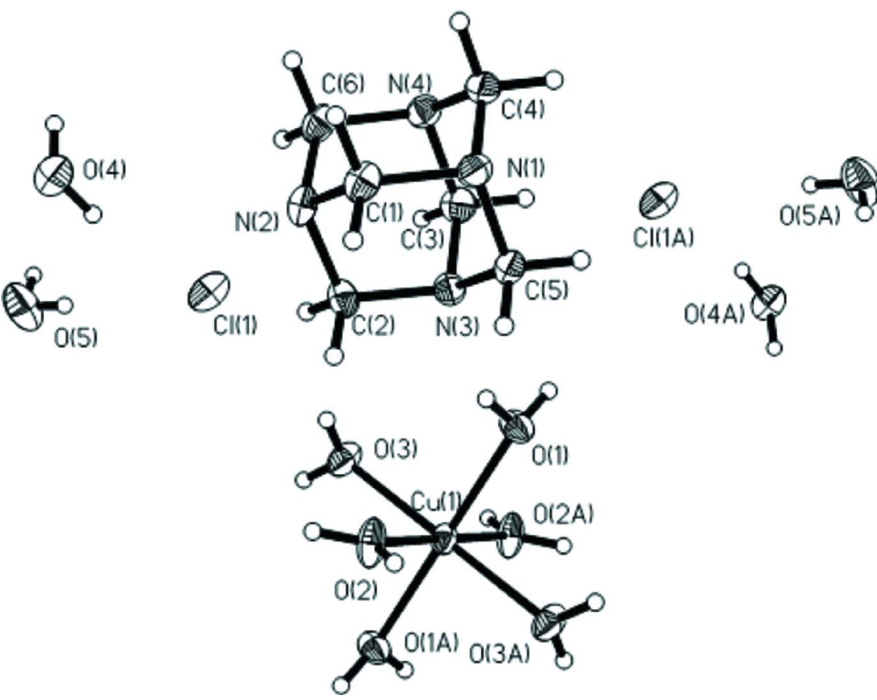
The asymmetric unit and symmetry related atoms of the title compound with 30% probability ellipsoids [symmetry code: (A) -x+1, -y,